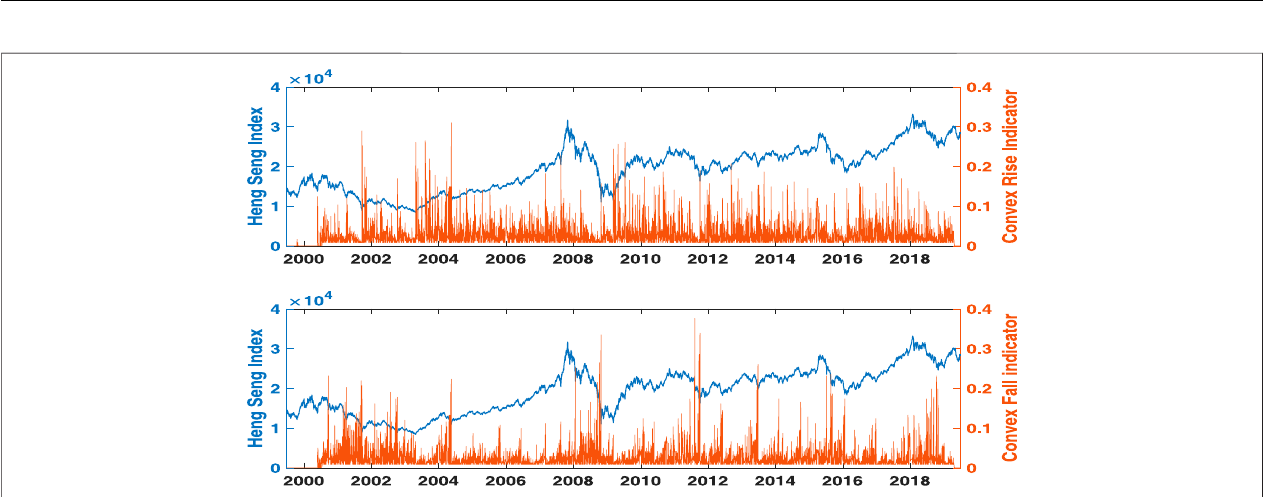
FIGURE5| PricemotionindicatorsmeasureDRandAFintheHangSengIndexfromJune28,1999,toJune28,2019.Convexriseandfallindicatorsareshownin the upper and lower panels, respectively. The Hang Seng Index is plotted using blue lines and indicators are represented using red bars. Here, the time scope is set to S (cid:2) 262, which is equal to the number of trading days per year.